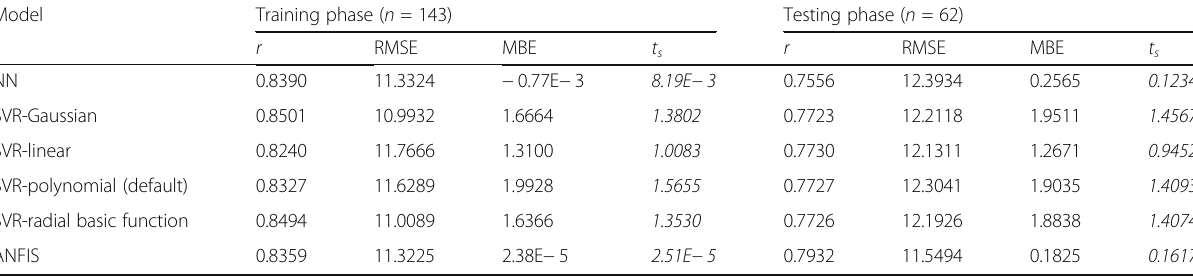
Table 4 Statistical results for soft computing in the estimations of cloudless DLR and the statistically significant models are in italics Model